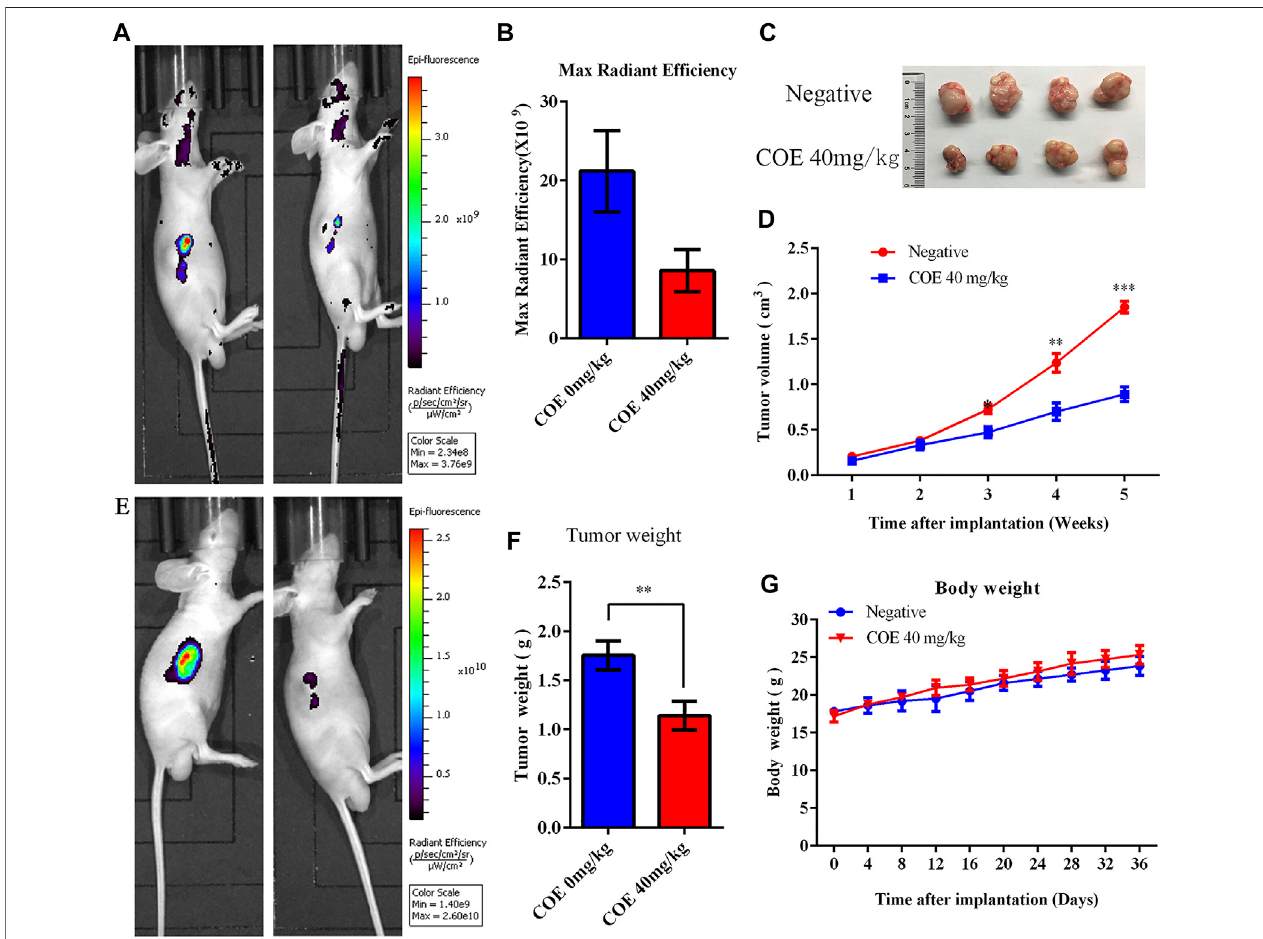
FIGURE 7 | Ethyl acetate extract of Celastrus orbiculatus (COE) inhibited the growth of gastric tumor xenografts in nude mice in vivo . (A) and (E) In vivo imaging of smallanimalshaveshown thatCOEcaninhibitgastrictumor growth invivo . (B) Statisticalresultsoftheimaging fl uorescenceintensity. (C) and (F) Sizeandweightofthe transplanted tumors. (D) Volume growth curve of the tumor. (G) Weight growth curve of nude mice.